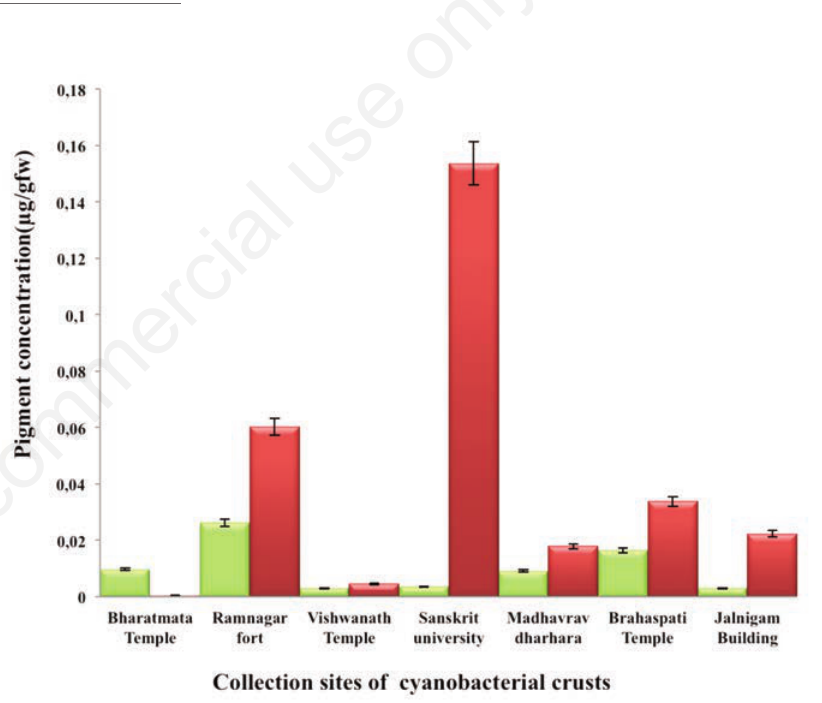
Figure 6. Pigment analysis of cyanobacterial samples collected from different historical monuments of Varanasi, India. All the experiments were repeated thrice with at least three replicates. Bars represent ± SD. Chlorophyll and total carotene contents are represented by green and red bars